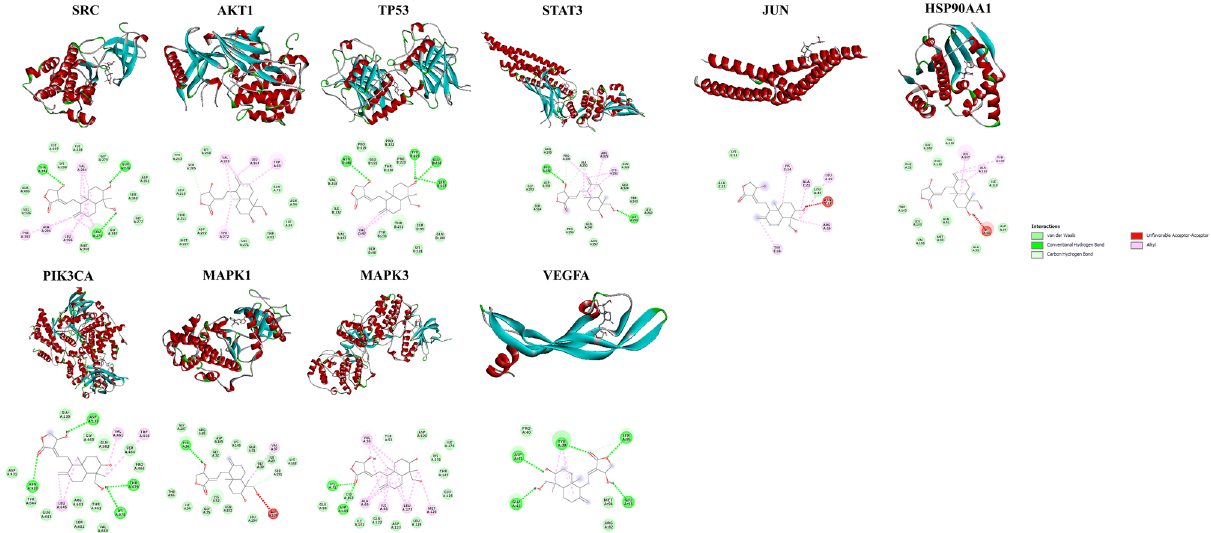
Figure 6. Molecular docking results of hub targets with andrographolide. (https:// disco ver. 3ds. com/ disco very- studio- visua lizer- downl